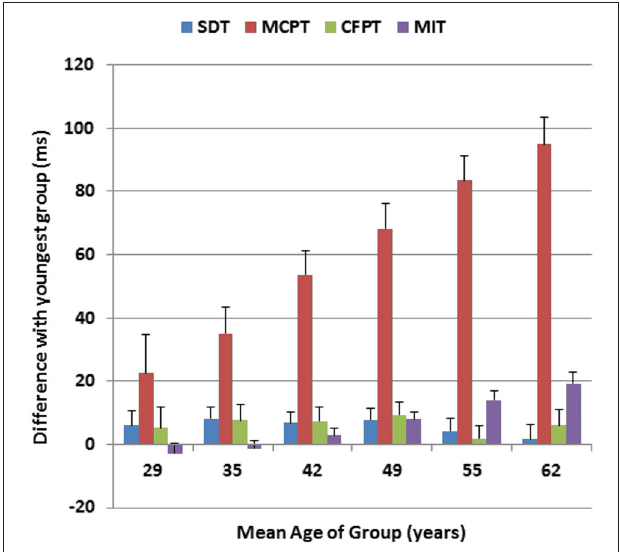
FIGURE 6 | Age-related changes in different processing stages for Experiment 1 . Changes in ms are shown relative to the duration of each processing stage in the youngest subjects (18–24 years). Stimulus detection time (SDT) and movement-initiation time (MIT) had been measured in previous tests performed on the same day. MCPT = Minimal CPT, the difference between CRTs to distractors with no target features and simple reaction times. CFPT = continued feature processing time, the difference between CRTs to distractors with target color or shape and distractors with no target features. Error bars show 95% confidence